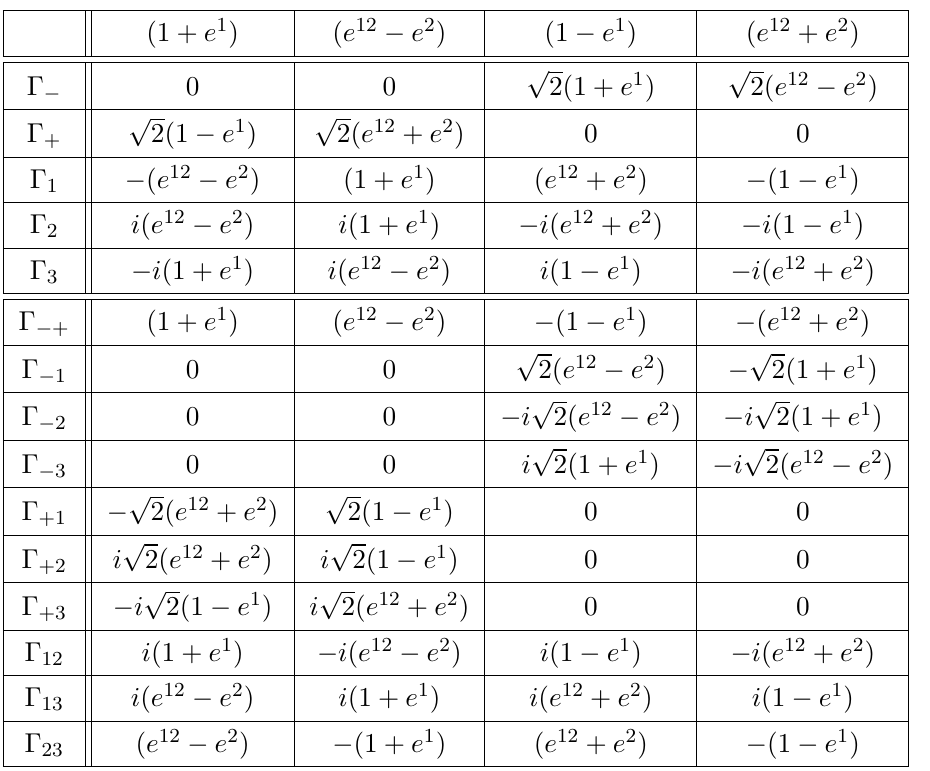
Table 2 . The action of the gamma matrices and the Spin(1 ; 4) generators on the di(cid:11)erent basis